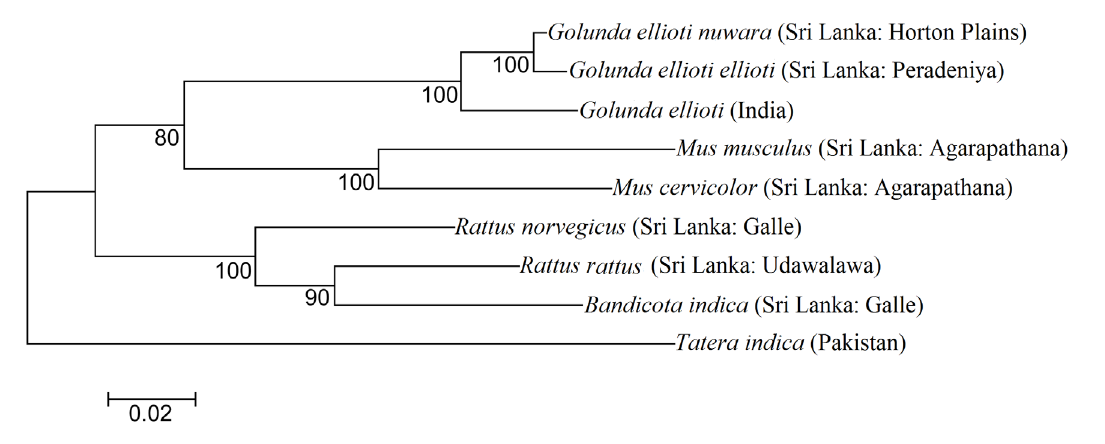
Figure 4: Maximum likelihood tree of cytochrome-b gene to show the placement of Golunda ellioti elioti and G. e. nuwara . Bootstrap values are presented below